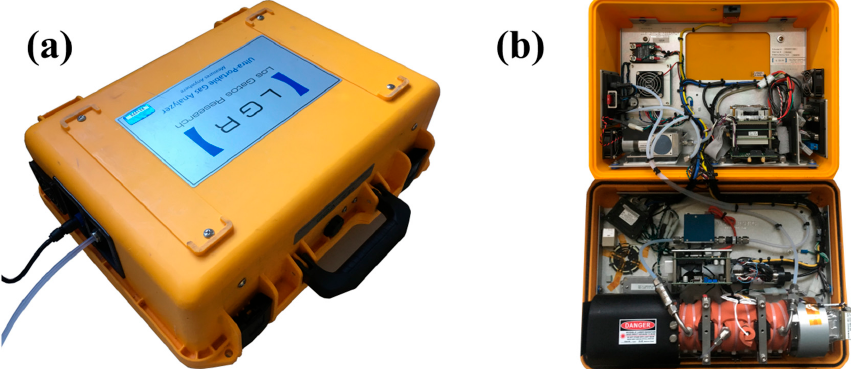
Figure A2. ( a ) The Ultra-portable Greenhouse Gas Analyzer (UGGA) with its lid closed and an air inlet attached; ( b ) the UGGA with its lid open.